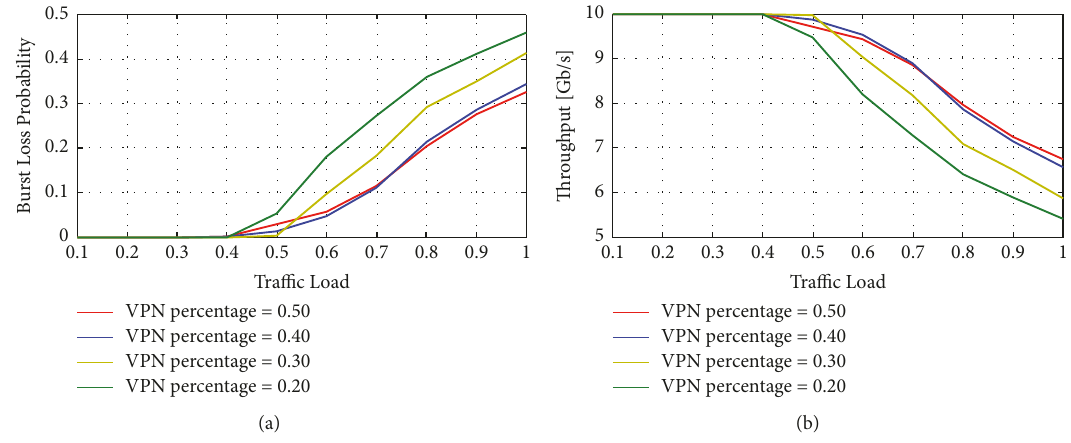
Figure 18: Network congestion for different values of % VPN : (a) burst loss probability versus traffic load; (b) throughput versus traffic load (N = 8 , M = 100 ).